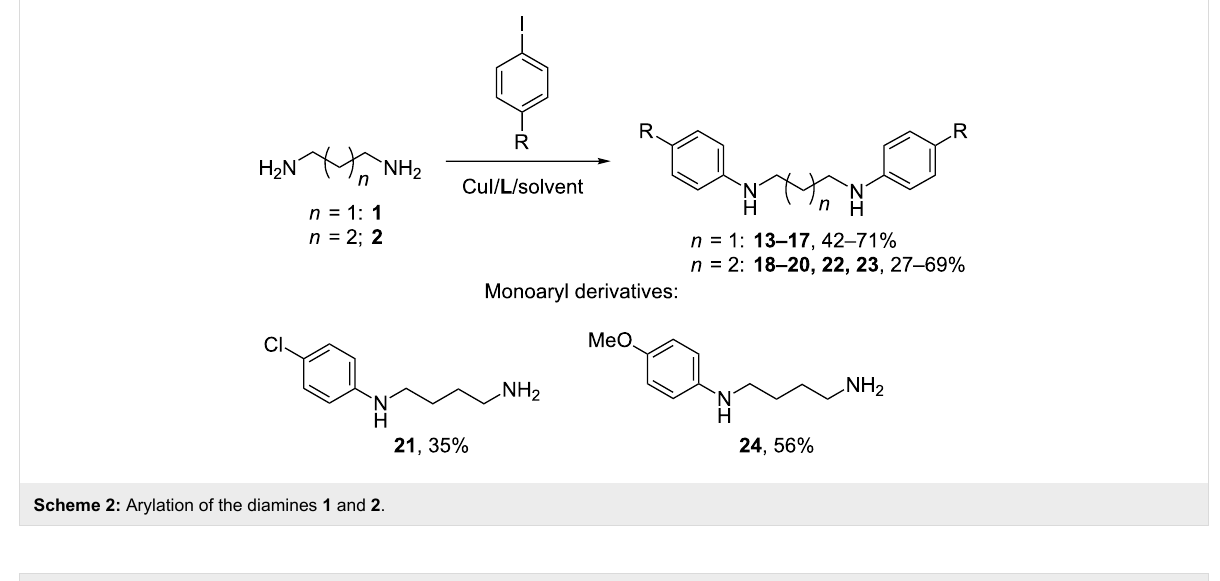
Scheme 2: Arylation of the diamines 1 and 2 .